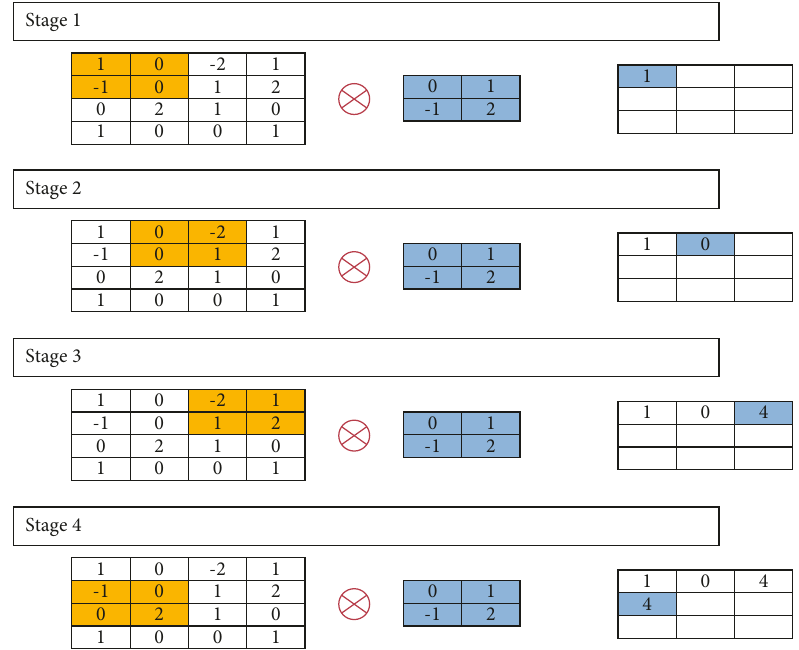
4 image; (b) kernel of size 2 ×